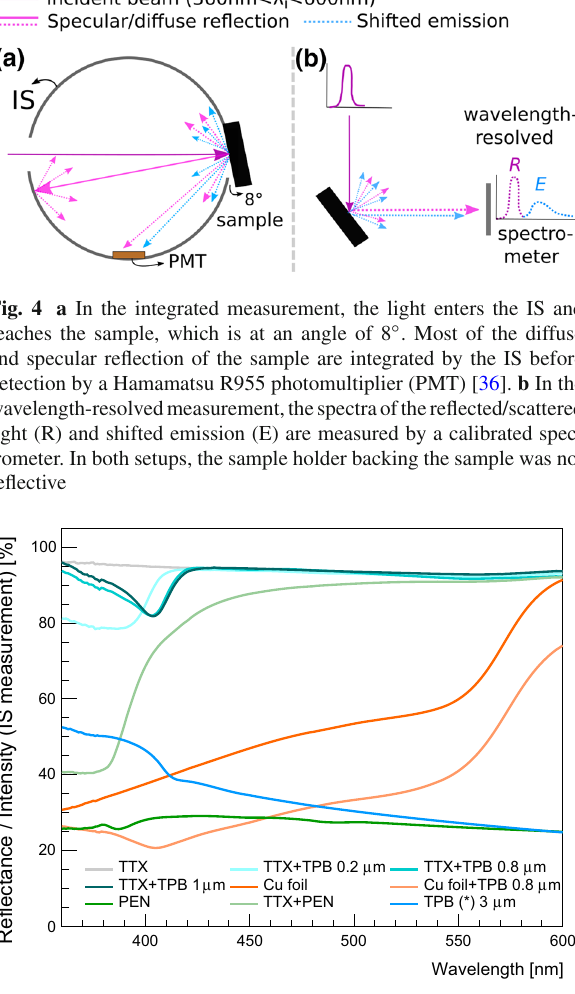
Fig. 5 Absolute reflectance (or intensity) [%] measured with the IS